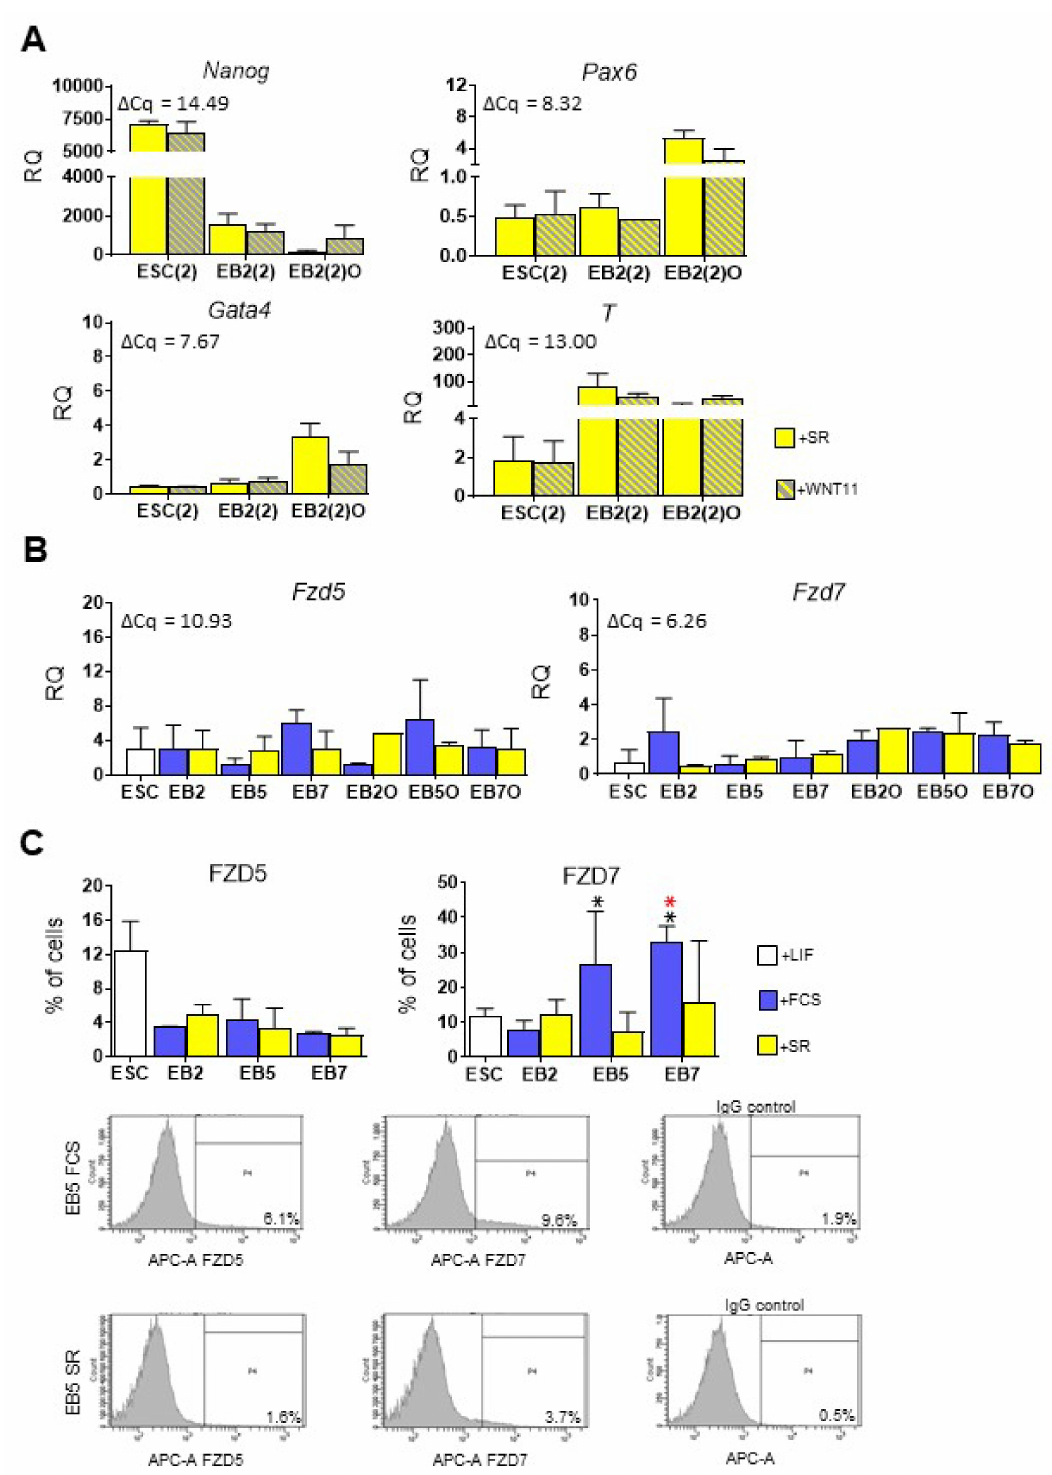
Figure 4. WNT11 treatment and analysis of WNT11 receptors in undifferentiated and differentiating ESCs. ( A ) Expression of Nanog , Pax6 , Gata4 and T in WNT11-treated and control ESCs, EBs and EBOs cultured in medium supplemented with SR. Cells were collected after 48h of WNT11 treatment. ( B ) Expression of WNT11 receptors: Fzd5 and Fzd7 . ( C ) FACS analysis: proportion of undifferentiated ESCs and cells obtained after disaggregation of EB2, EB5, and EB7 synthesizing FZD5 or FZD7. Data presented as means of three independent experiments with standard deviations. Representative histograms present proportion of EB5-derived cells synthesizing FZD5 or FZD7 or cells incubated with IgG only (negative